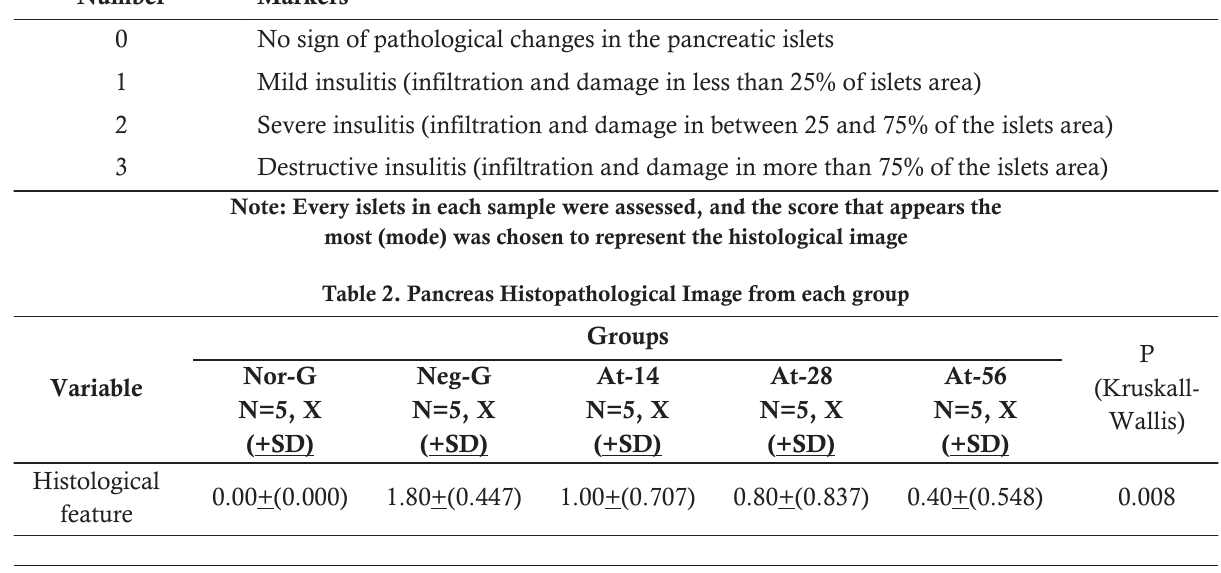
Figure 1. Histological feature of Pancreatic islets injury following antlion treatment in each group. Microscopic investigation of pancreas from normal control group (Nor-G) showed the normal appearance of pancreatic islets, lightly stained than the surrounding acinar cells. Pancreas from the Neg-G mice showed collapsed islet architecture and tissue damage. Severe mononuclear cell infiltration were also found. On the other hand, histological images from At-14, At-28, and At-56 showed alleviation in the tissue damage and reduction mononuclear cell infiltration gradually. The lowest pancreatic islet damage was found in At-56, showing almost no tissue damage and infiltration. P: pancreatic islet. Mann Withney test: * p<0.05; ns: not significant